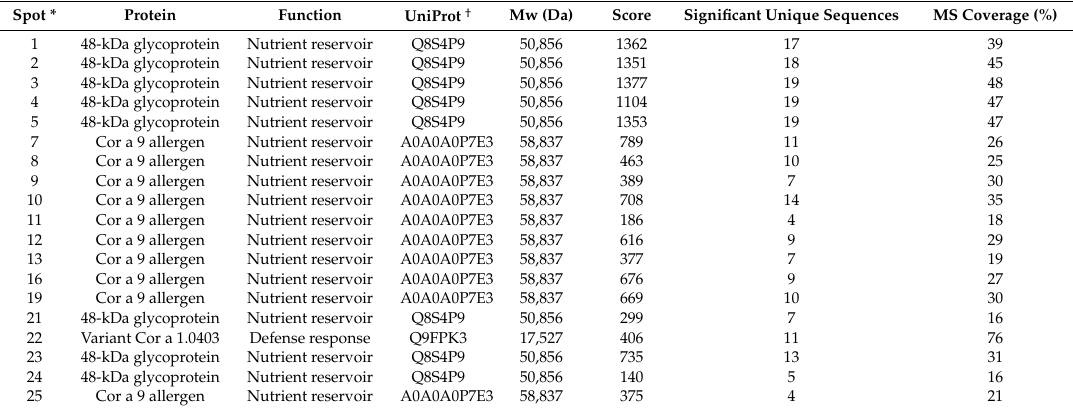
Table 2. Mass spectrometry-identified proteins of the ‘Merveille de Bollwiller’ ( Corylus avellana L.) 2DE profile, corresponding to immunoreactive spots.